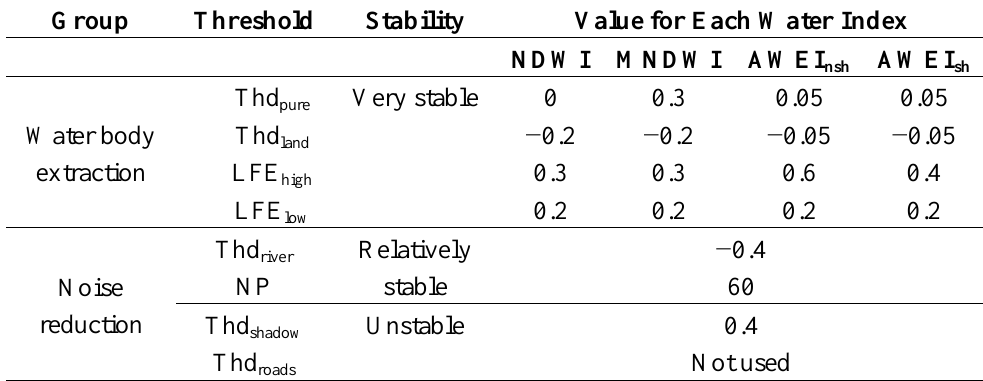
Table 3. AMERL parameters; the values correspond to those used in study area 1. Thd, threshold. NP, number of